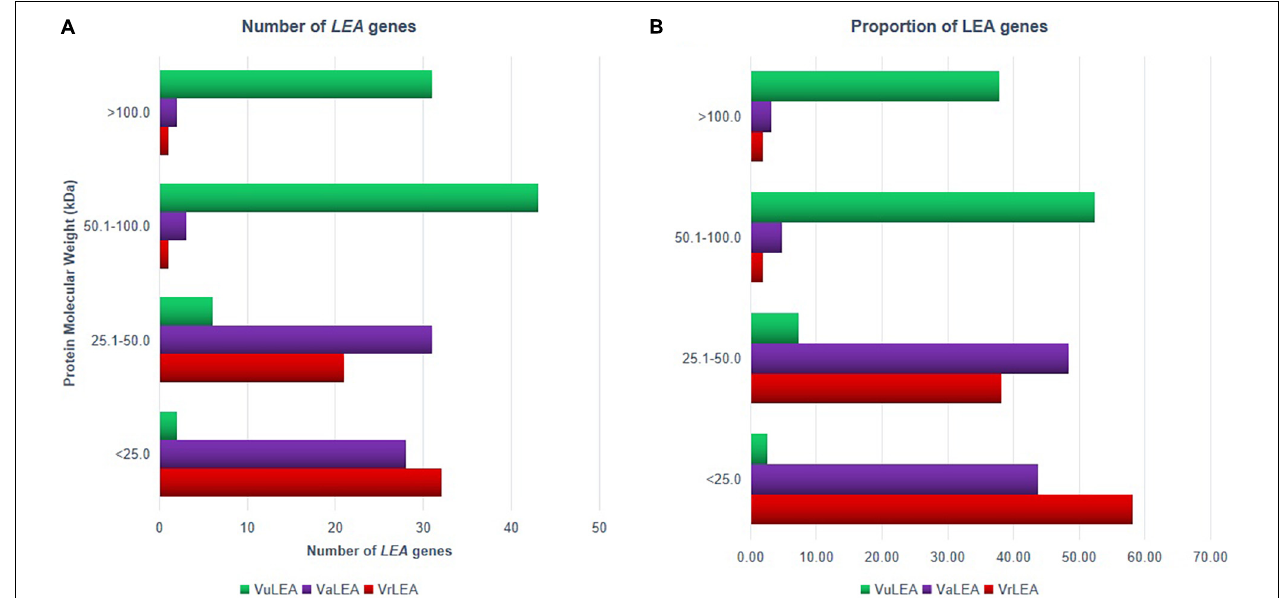
FIGURE 9 | (A) Number and (B) proportion of LEA protein in VrLEA , VaLEA , and VuLEA gene families based on their molecular